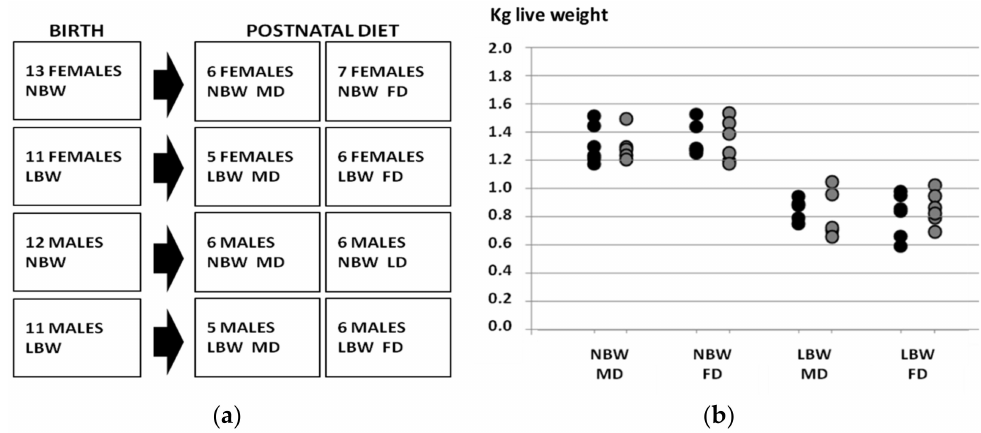
Figure 1. Study design ( a ) and birth weights of the piglets in the four groups of the study ( b ). NBW: normal birth weight; LBW: low birth weight; MD: maintenance diet; FD: fattening diet; black circles: males; grey circles: